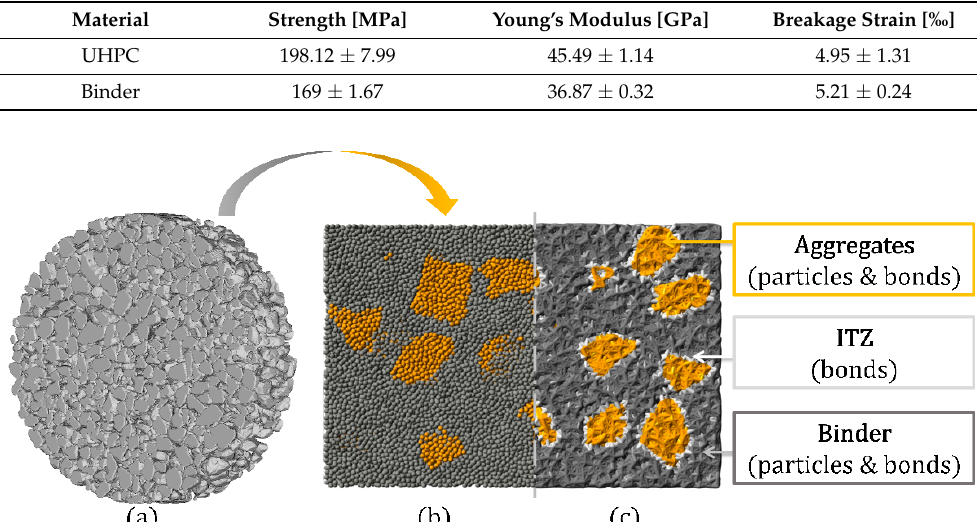
Table 3. Simulation results obtained from uniaxial compression tests.